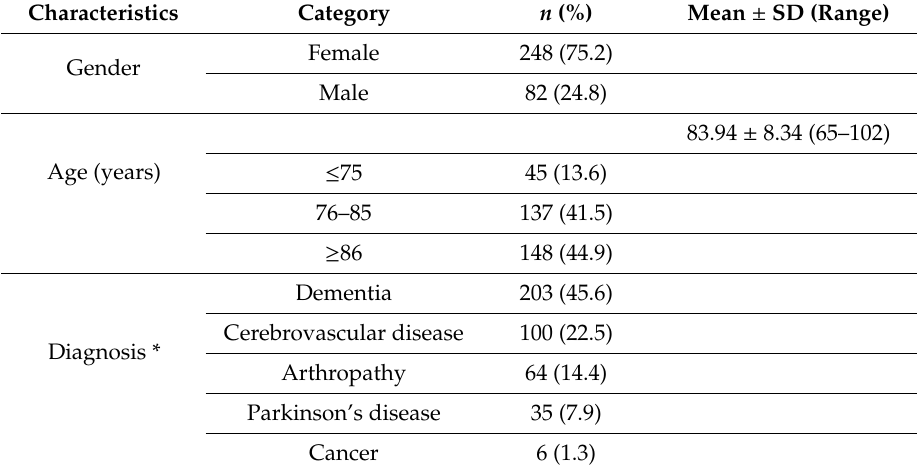
Table 2. Characteristics of the residents at long-term care facilities (LTCFs), N =